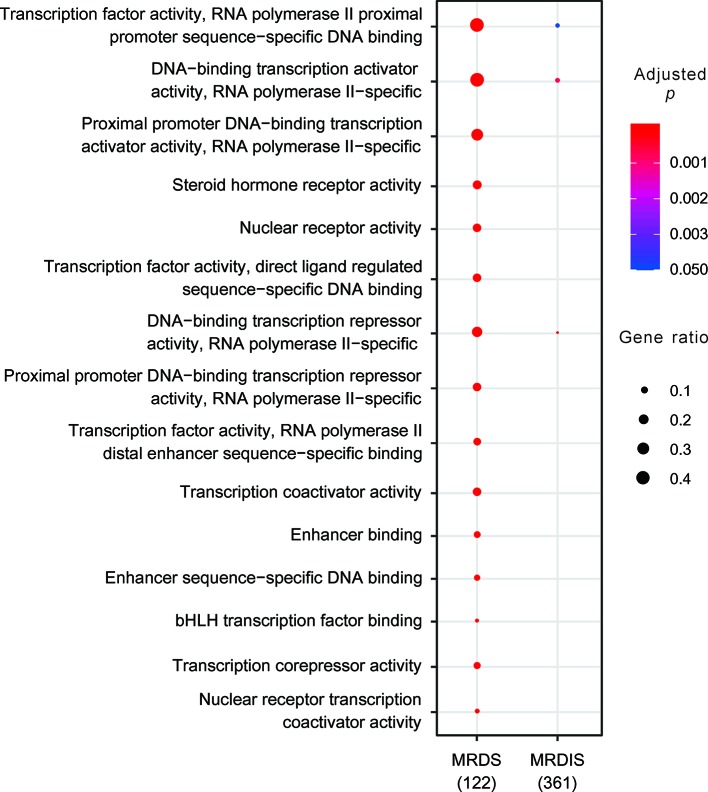
Clear differences in the Gene Ontology enrichment between most reliable dosage-sensitive (MRDS) transcription factors (TFs) and most reliable dosage-insensitive (MRDIS) TFs. Due to space limitations, only the most significant terms of the MRDS TFs are displayed. The color of each circle represents the significance of the enrichment adjusted using the Benjamini-Hochberg (BH) procedure and the size of each circle represents the percentage of genes associated with that term.